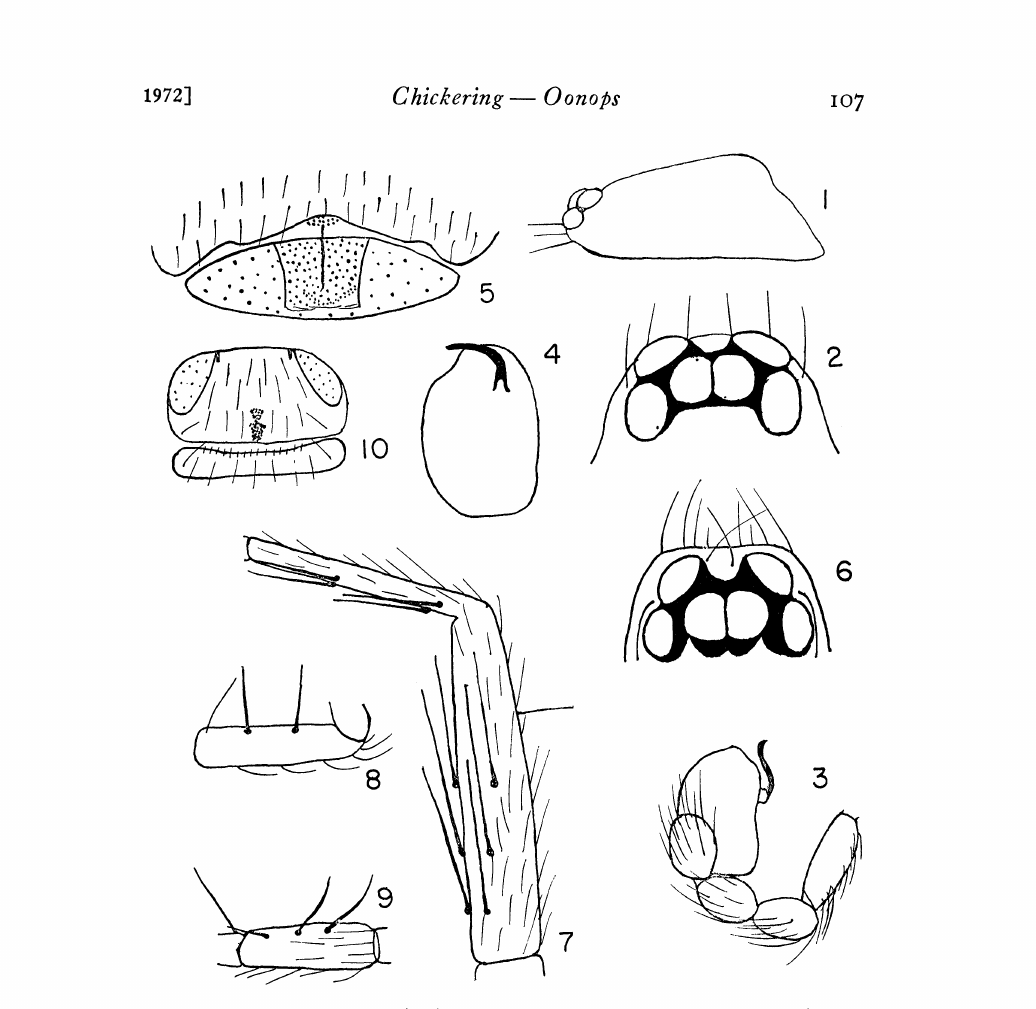
Figures 1-5. Oonops aristelus sp. nov. Fig. 1. Carapace of holotype; left lateral view. Fig. 2. Eyes of holotype from above. Fig. 3. Left palp of holotype; prolateral view. Fig. 4. Left palpal tarsus of holotype; ven- tral view. Fig. 5. Epigynal area of described female paratype from below. Figures 6-10. Oonops delegenus sp. nov. Fig. 6. Eyes of holotype from above. Fig. 7. First right tibia and metatarsus; prolateral view. Fig. $. Left palpal femur; retrolateral view. Fig. 9. Left palpal patella; dorsal view. Fig. 10. Epigynal area of holotype; ventral